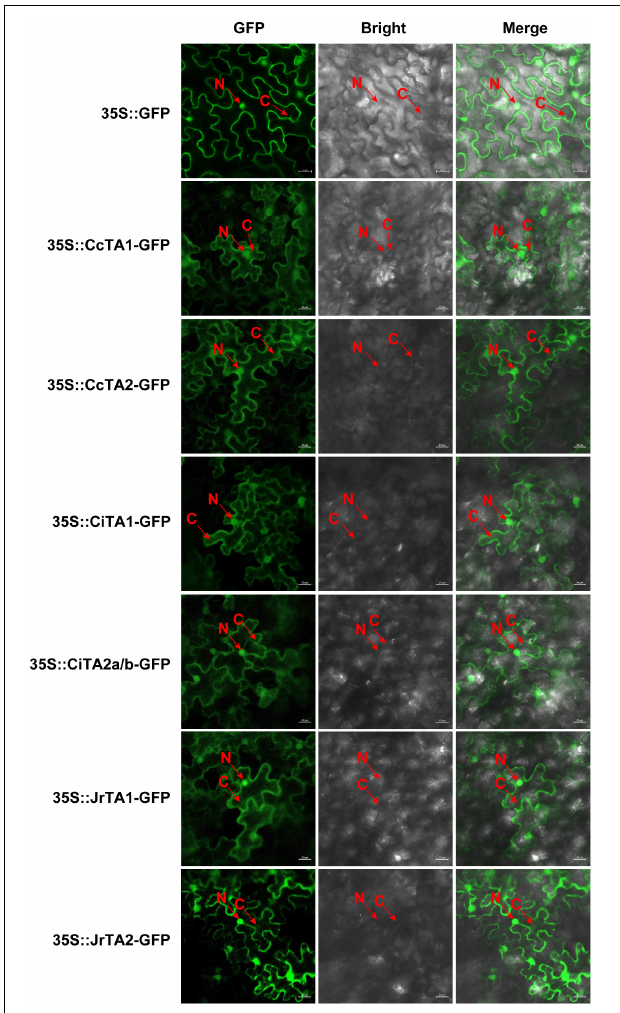
FIGURE 1 | Subcellular localization analysis of TA genes in Juglandaceae. The protein subcellular localization was performed by Agrobacterium tumefaciens -mediated transient expression in N. benthamiana leaves. GFP fluorescence was observed and examined using a laser confocal fluorescence microscopy (excitation: 488 nm; emission: 495–515 nm) (LSM 800, Zeiss, Germany). Scale bar in images is 20 µ m. Red arrows indicate important areas (N stands for the nucleus and C stands for the